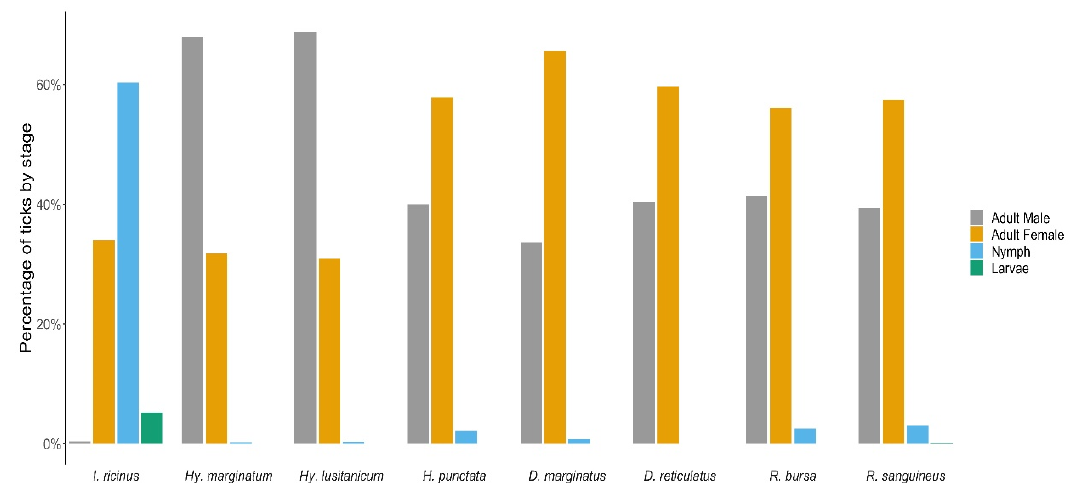
Figure 3. Number of tick species according to developmental stages.